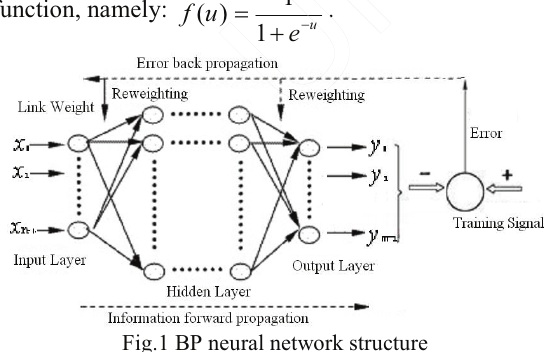
Fig.1 BP neural network